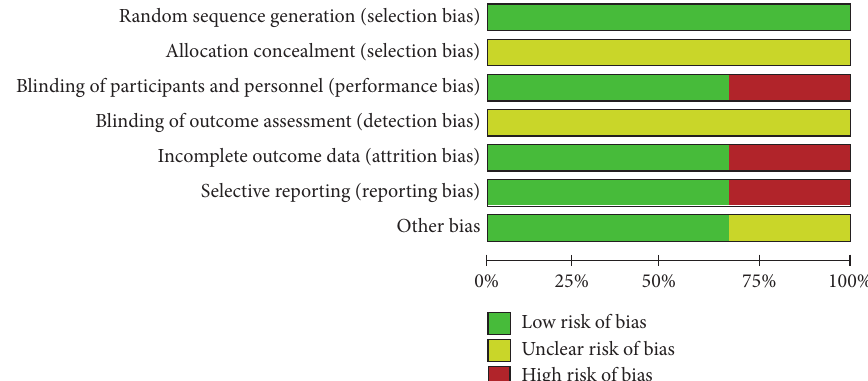
Figure 4: Effect of ultrasound-guided radiofrequency (RF) on the pain scores in patients with knee osteoarthritis (KOA). VAS: visual analogue scale; NRS: numerical rating